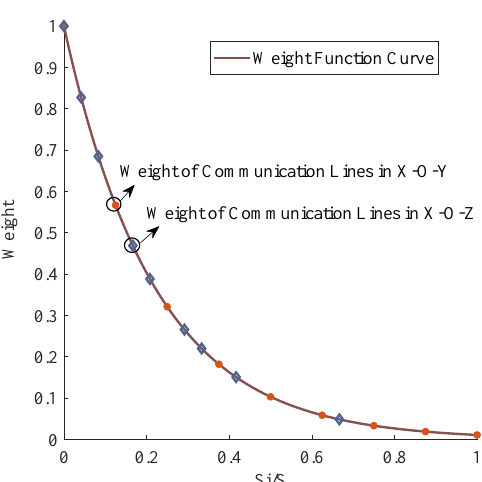
Figure 9. The relationship between the weight and the S i / S of link i in the X-O-Y and the X-O-Z planes, according to the exponential decay function.